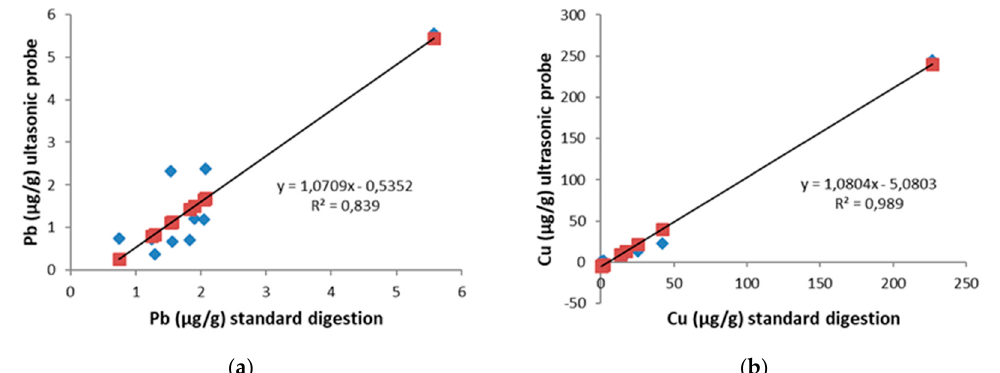
Figure 3. Regression curves obtained for correlation between standard acid digestion and ultrasonic probe-assisted acid digestion ( a ) Pb ( μ g/g); ( b ) Cu ( μ